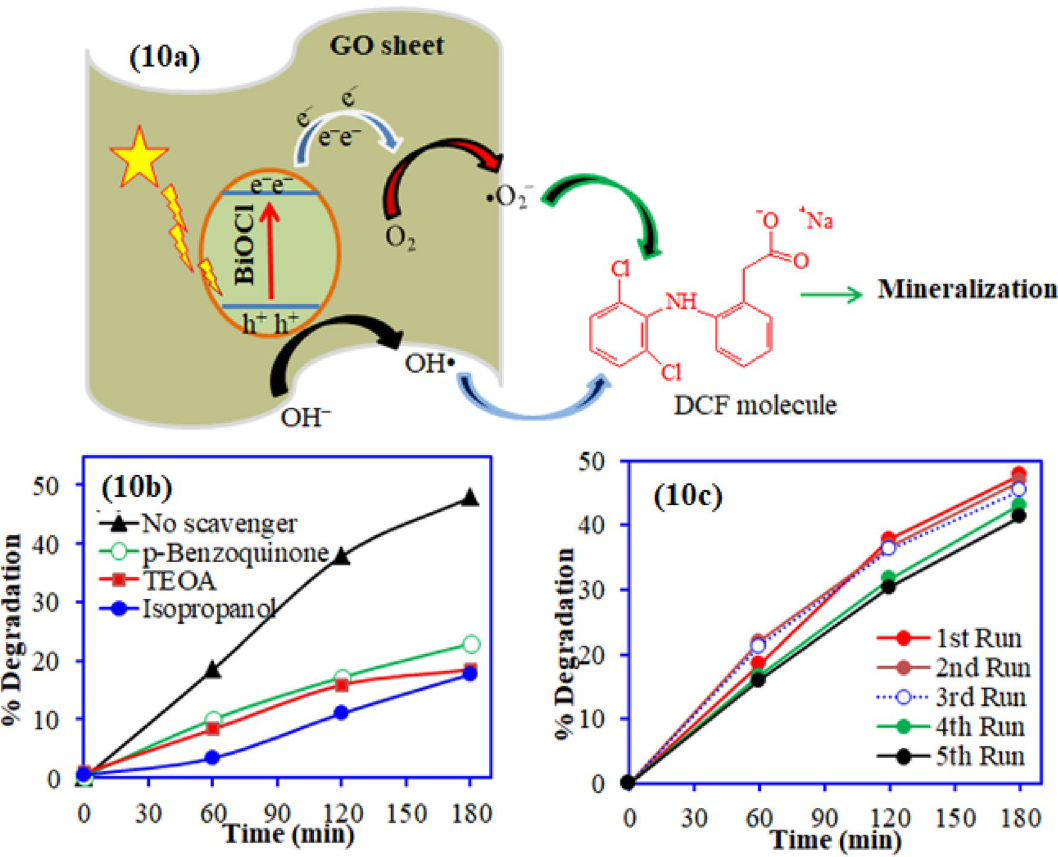
Figure 10. ( a ) Schematic representation for DCF photocatalytic degradation mechanism onto BiOCl–GO composite; ( b ) Effect of different scavengers on DCF degradation and ( c ) Plot for regeneration of spent BiOCl– GO composite. Photocatalyst Pollutant Initial conc.(mg/L) Removal (%) conditions